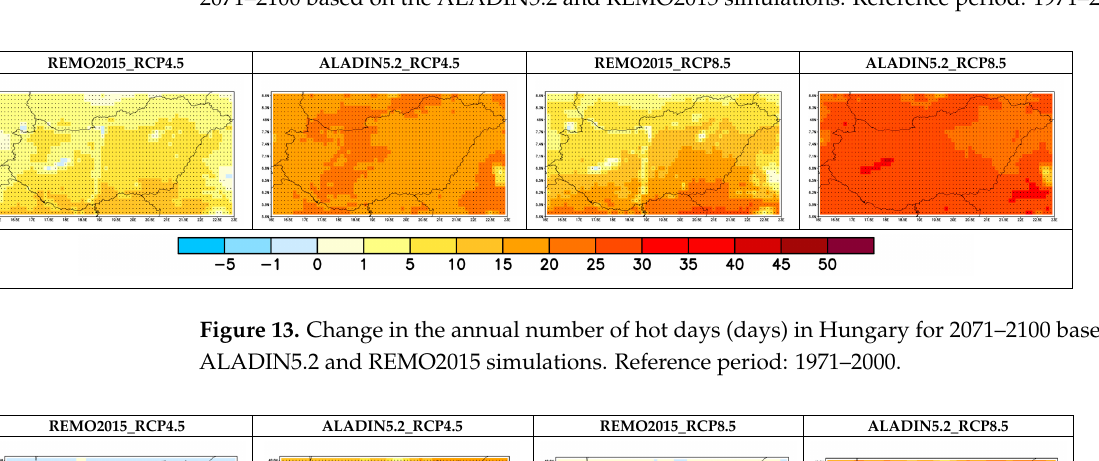
Figure 12. Change in the annual number of summer days (days) in Hungary for 2021–2050 and 2071–2100 based on the ALADIN5.2 and REMO2015 simulations. Reference period: 1971–2000. Atmosphere 2023 , 14 , x FOR PEER REVIEW